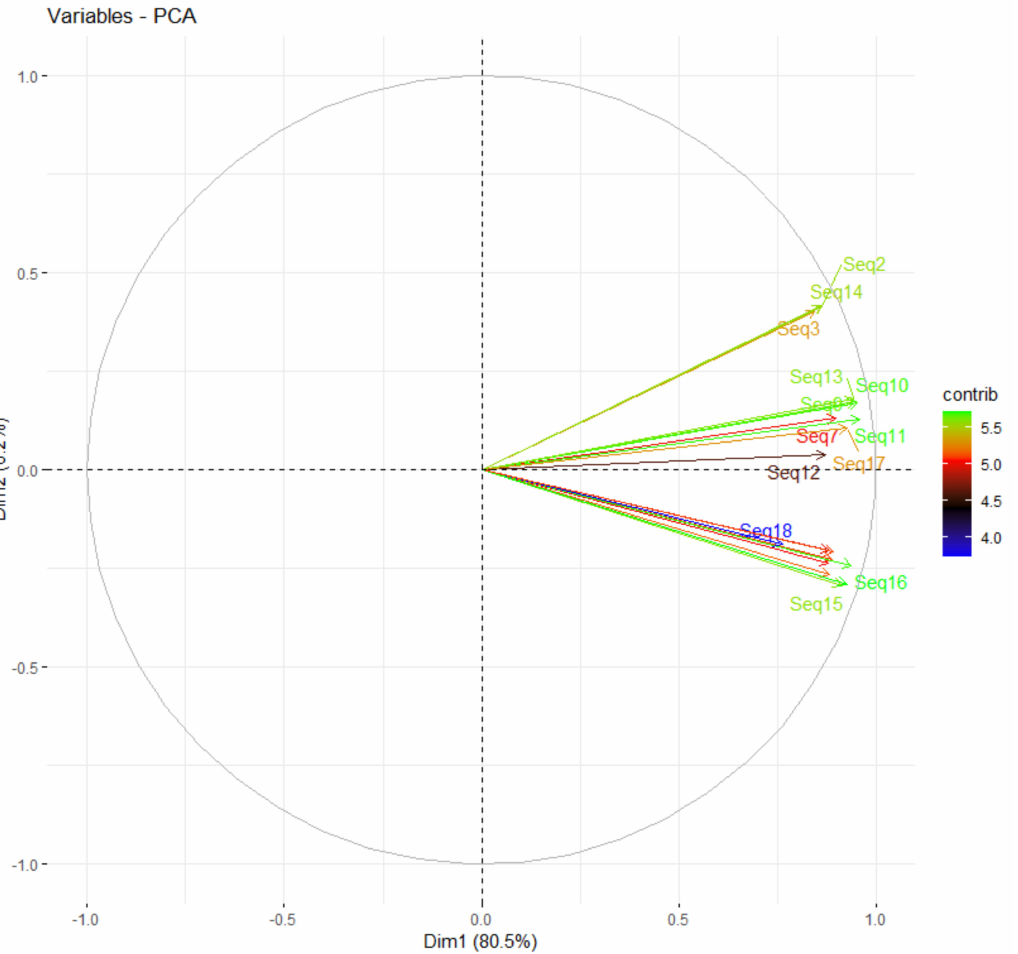
Figure 4. The percentage of two dominations explains variability through principal components for 19 mRNA sequences related to heat shock proteins for the Solanum lycopersicum cultivar Heinz 1706, the right legend shows the contributions of variables to PCs. Dim1 expresses dimension 1 while Dim2 expresses dimension